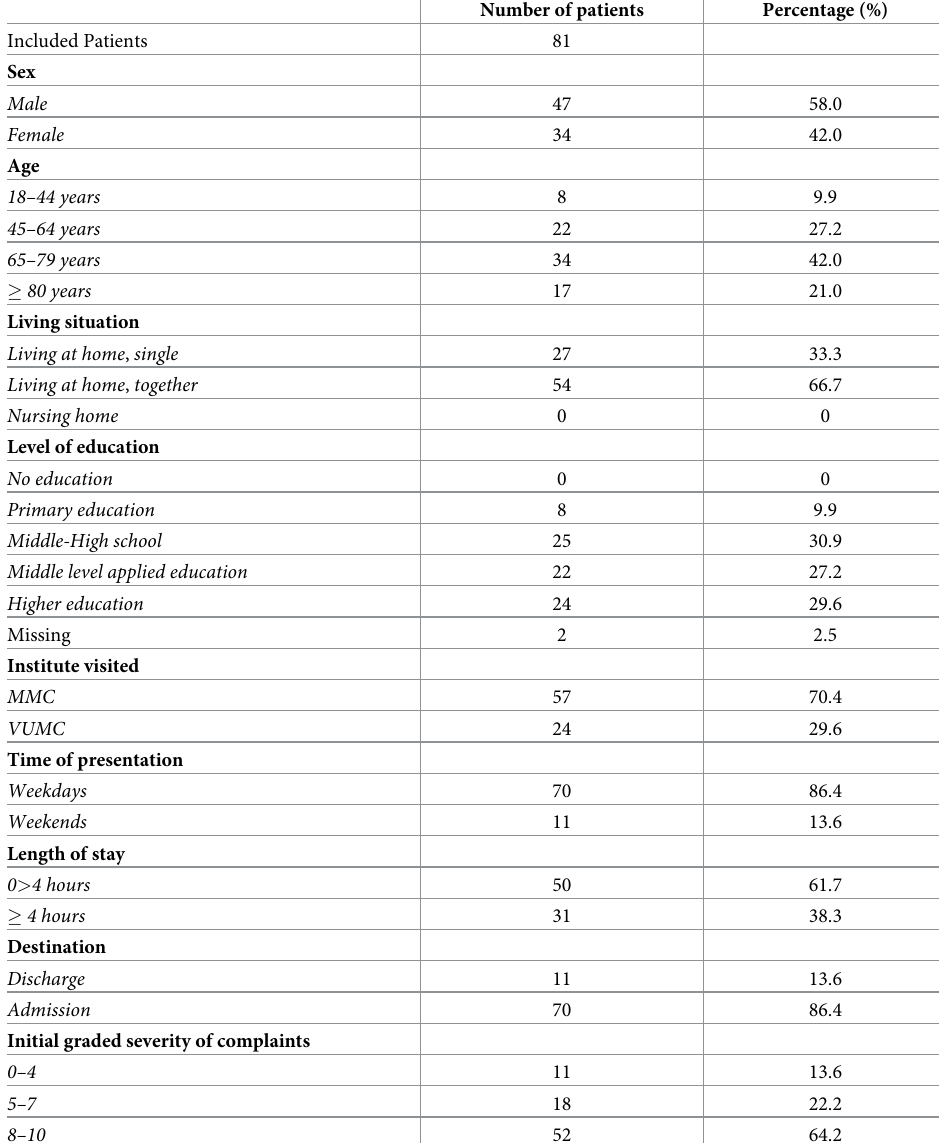
Table 1. Patient